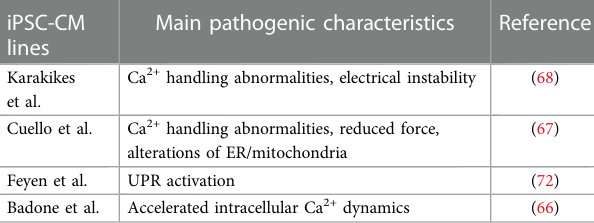
TABLE 2 PLN-R14del iPSC-CMs and pathogenic